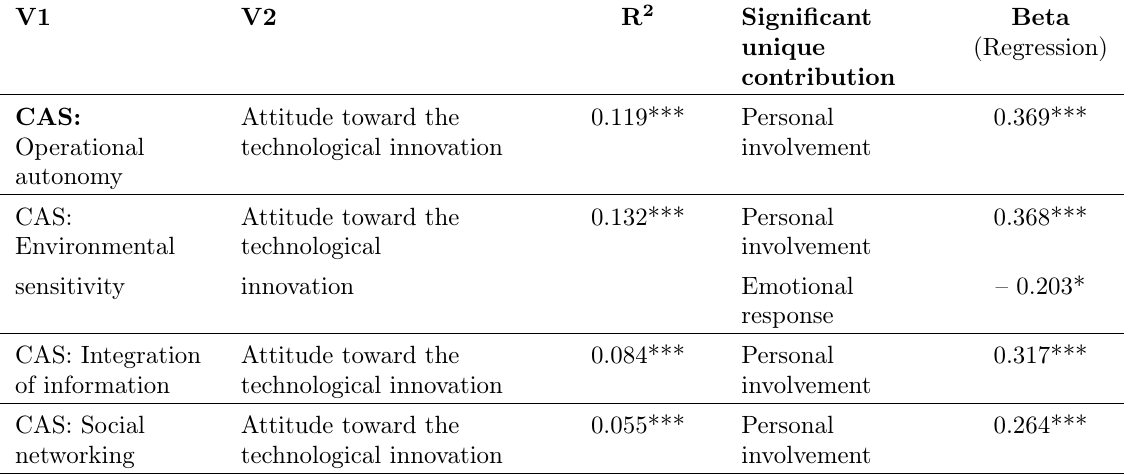
Table 2. Predictive indicators of the variable: Attitude toward the technological innovation [by 3 dimensions: degree of influence, personal involvement, and emotional response] V1 V2 R 2 Significant